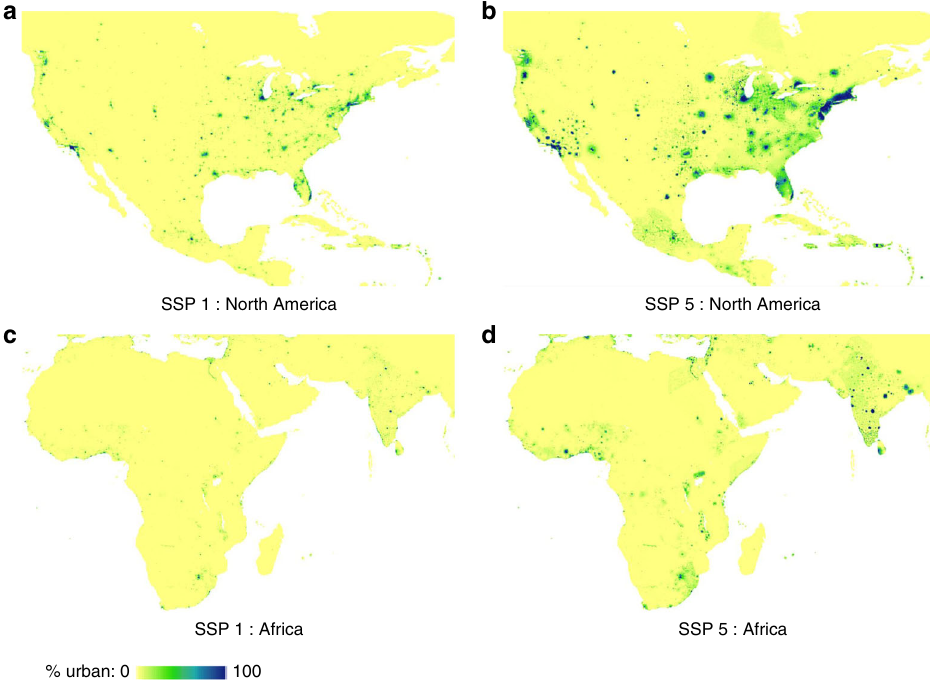
Fig. 3 2100 spatial urban land maps. This fi gure compares the sustainability scenario (SSP 1) and the fossil-fueled development scenario (SSP 5) for the most developed and the fastest developing continents (North America and Africa, respectively). a North America under SSP 1. b North America under SSP 5. c Africa under SSP 1. d Africa under SSP 5.